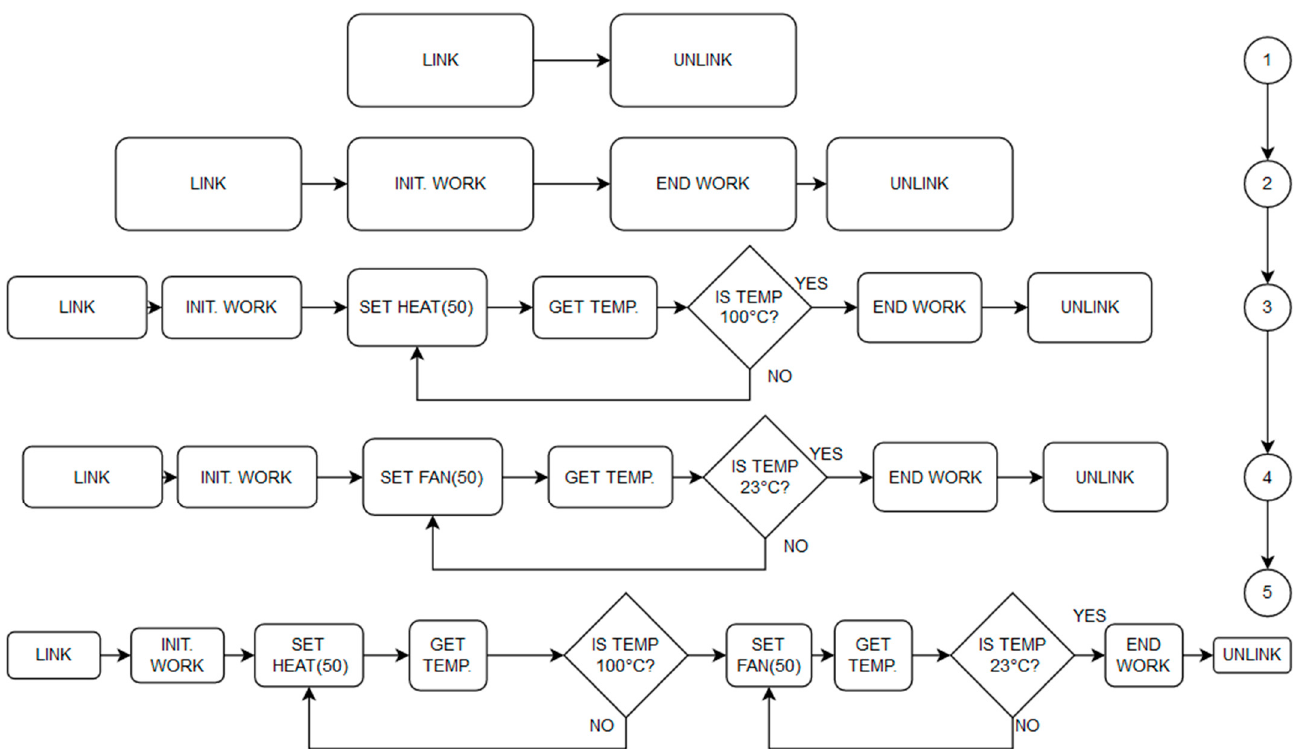
Figure 10. Gradual buildup of the code’s logic, testing every command and their performance. Circular labels indicate “stages” within the gradual buildup.